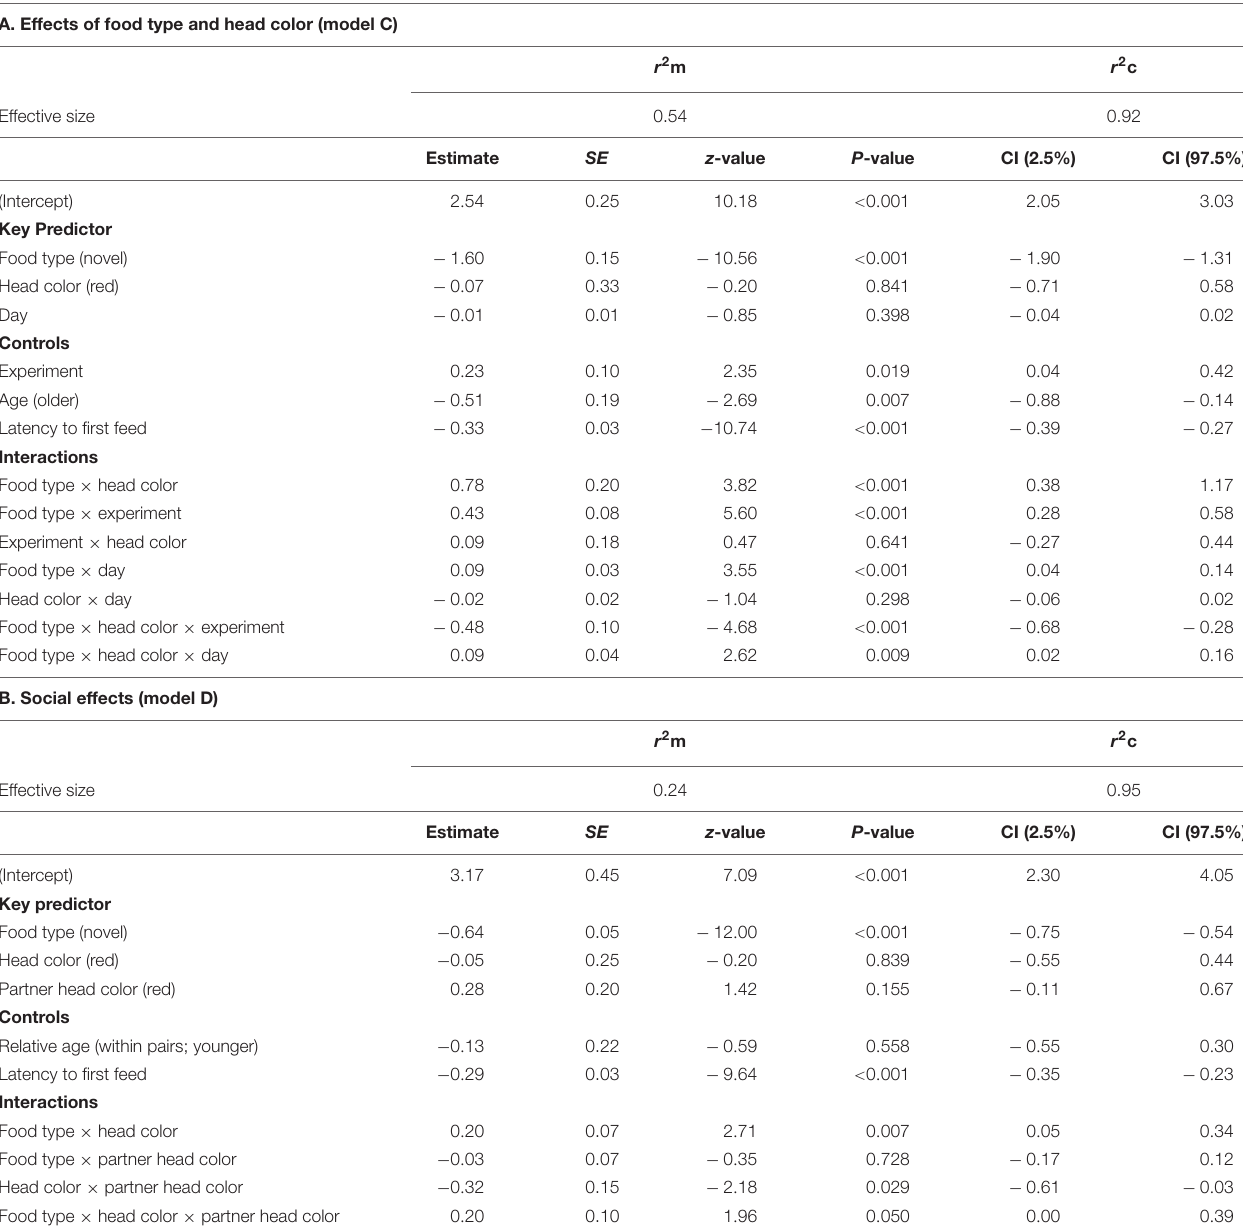
TABLE 5 | Results of the general linear mixed effects model on the frequency of feeding visits after first feed on familiar and novel food (rate of incorporation of novel food into the diet) of Gouldian finches addressing (A) the effect of food type and color morph (model C) and (B) social effects (model D). Only the final model of each analysis is shown. The reference modality is in